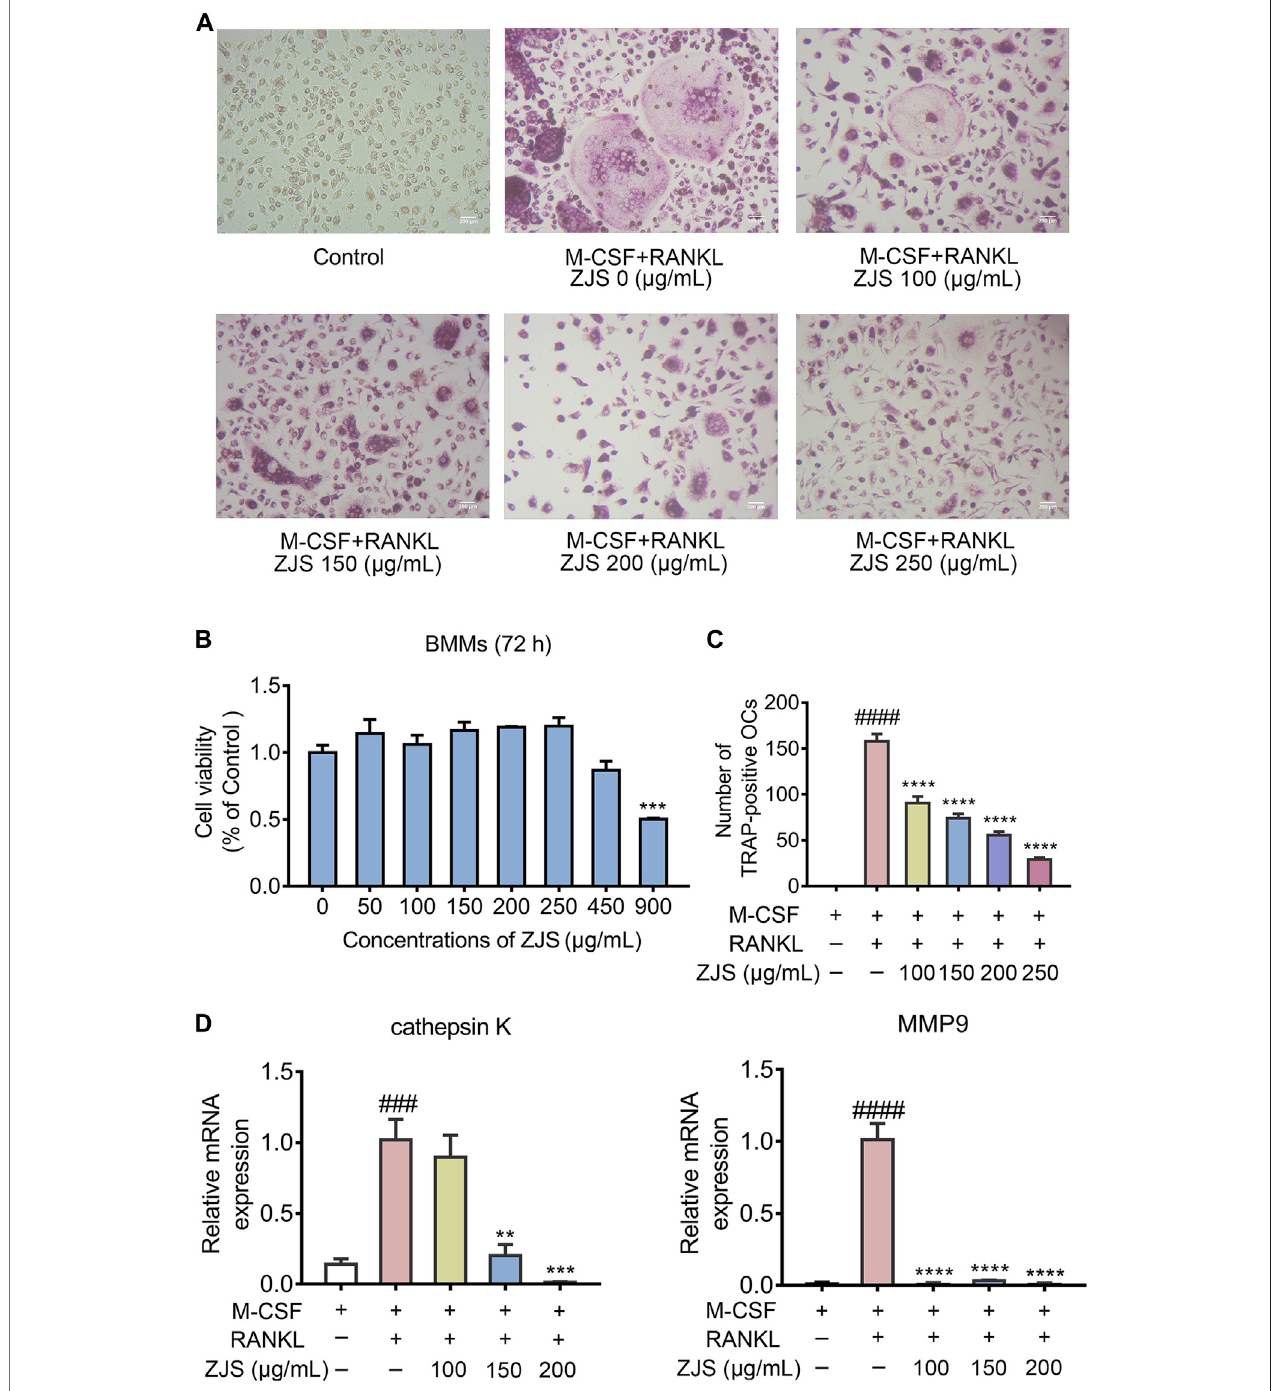
FIGURE 5 | ZJS inhibited the differentiation of osteoclasts and the mRNA expression of osteoclast-related genes in vitro. (A) Representative images of TRAP- positive cells in BMMs treated with the indicated concentrations of ZJS followed by stimulation with RANKL (scale bars (cid:1) 200 μ m). (B) Cell viability was evaluated using MTT assay ( n (cid:1) 3). (C) The number of TRAP-positive multinucleate osteoclasts treated with indicated concentrations of ZJS followed by stimulation with RANKL ( n (cid:1) 3). (D) The mRNA expression levels of cathepsin K and MMP9 in BMMs in the indicated groups were determined by real time qPCR analysis, β -actin was used as the internal reference ( n (cid:1) 3). Values are presented as the mean ± SEM. ### p < 0.005, #### p < 0.001, compared with the RANKL-untreated group. **p < 0.01, ***p < 0.005, ****p < 0.001, compared with the RANKL + ZJS-untreated group (One-way ANOVA test).